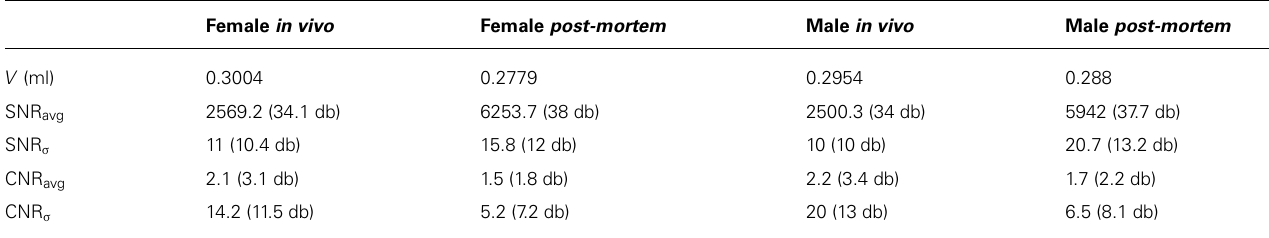
Table 1 | Quantitative results from post-processing. Female in vivo Female post-mortem Male in vivo Male